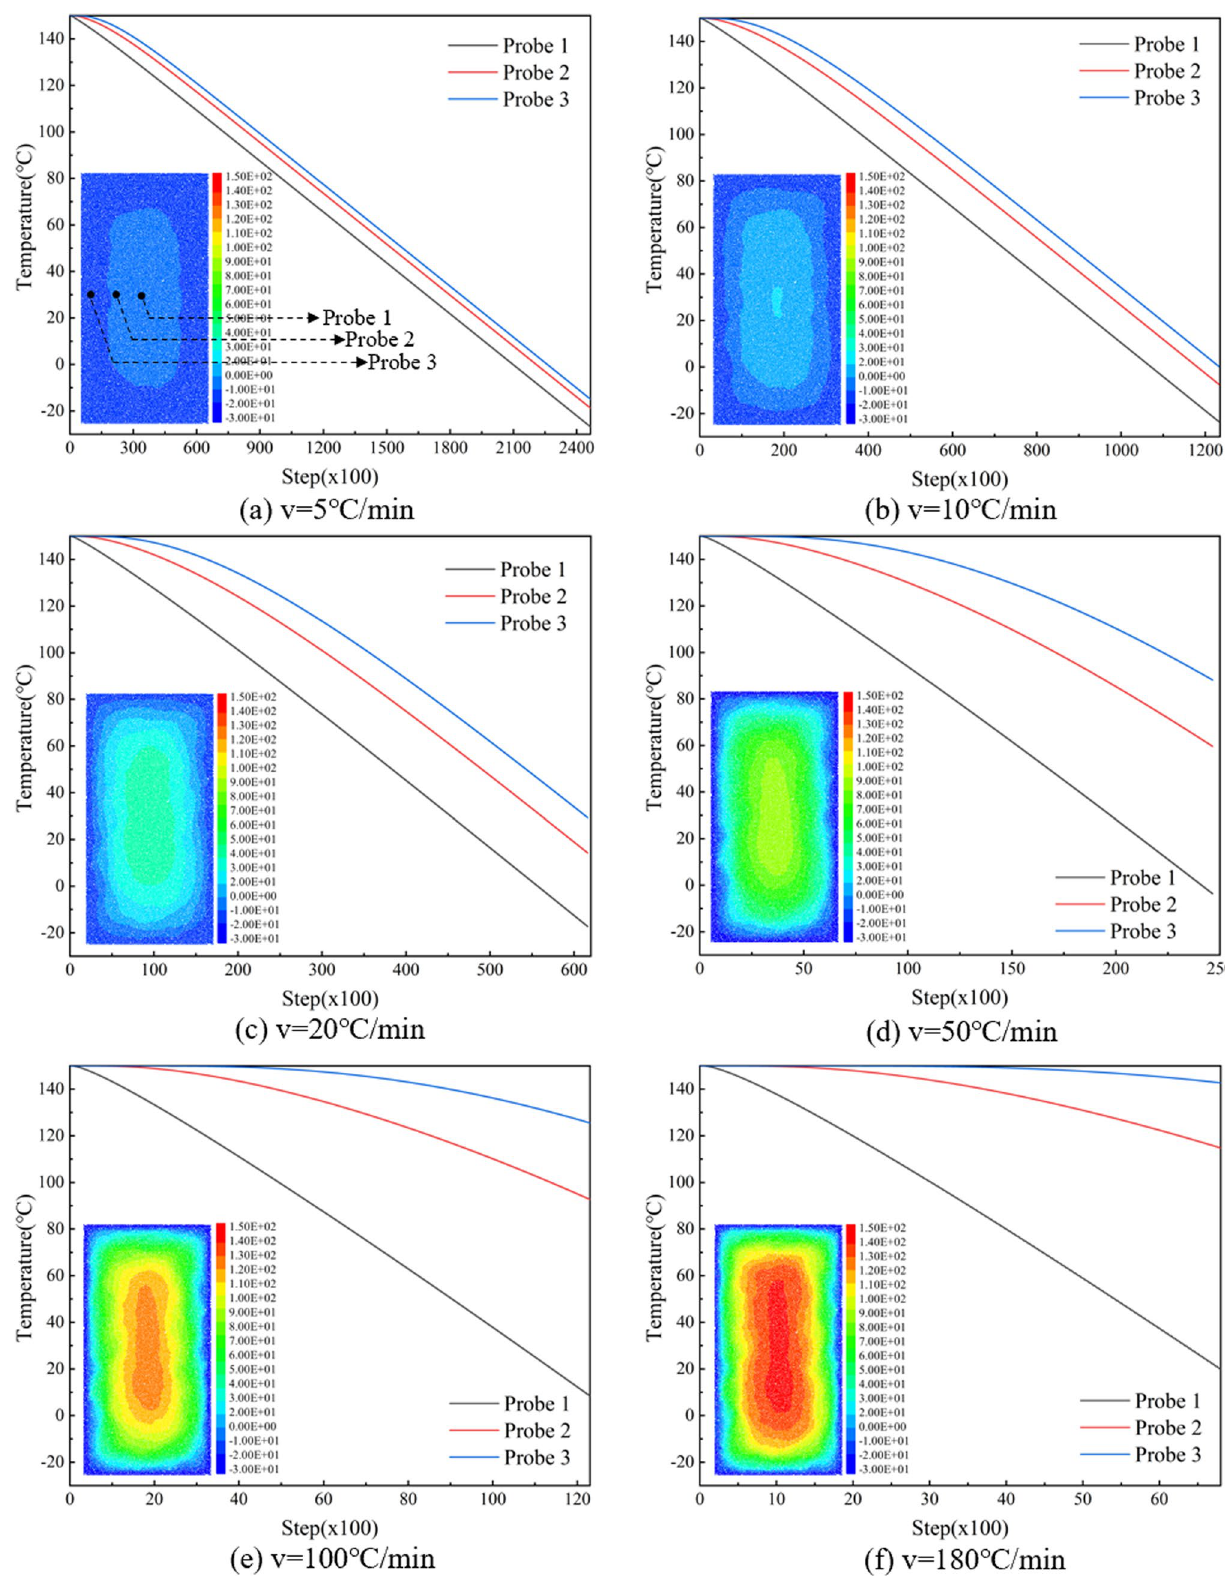
Fig. 14 Variation of temperature probe with loading